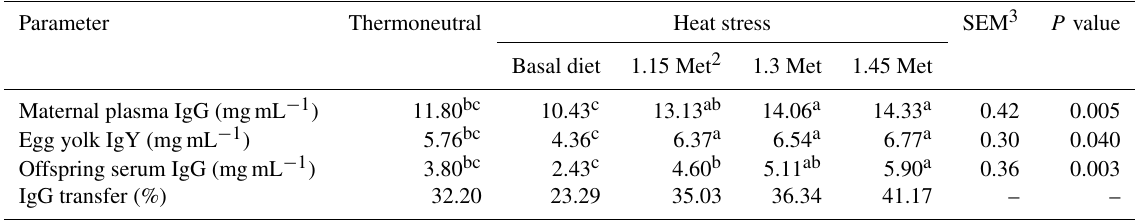
Table 5. Effect of methionine on maternal serum IgG, egg yolk IgY, offspring serum IgG (mgmL − 1 ) and IgG transfer 1 in breeder quails.